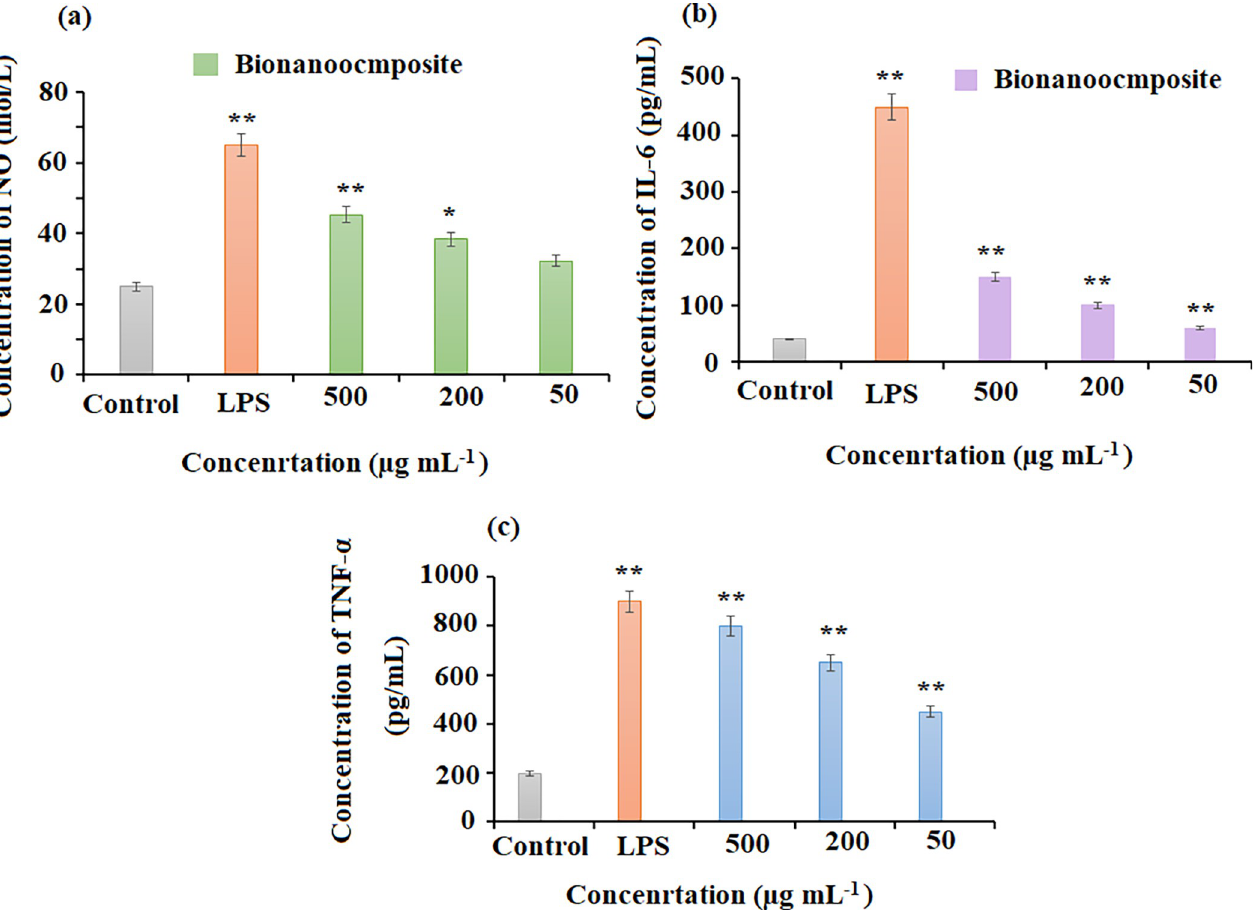
Fig 10. Effect of sunflower oil/FA–CSNPs bionanocomposite on the production of cytokines (a) NO, (b) IL–6, and (c) TNF– α . The data are expressed as mean ± standard deviation (n = 3). The significant differences between the treated cells and the control cells were calculated as * P < 0.05 or ** P < 0.01.